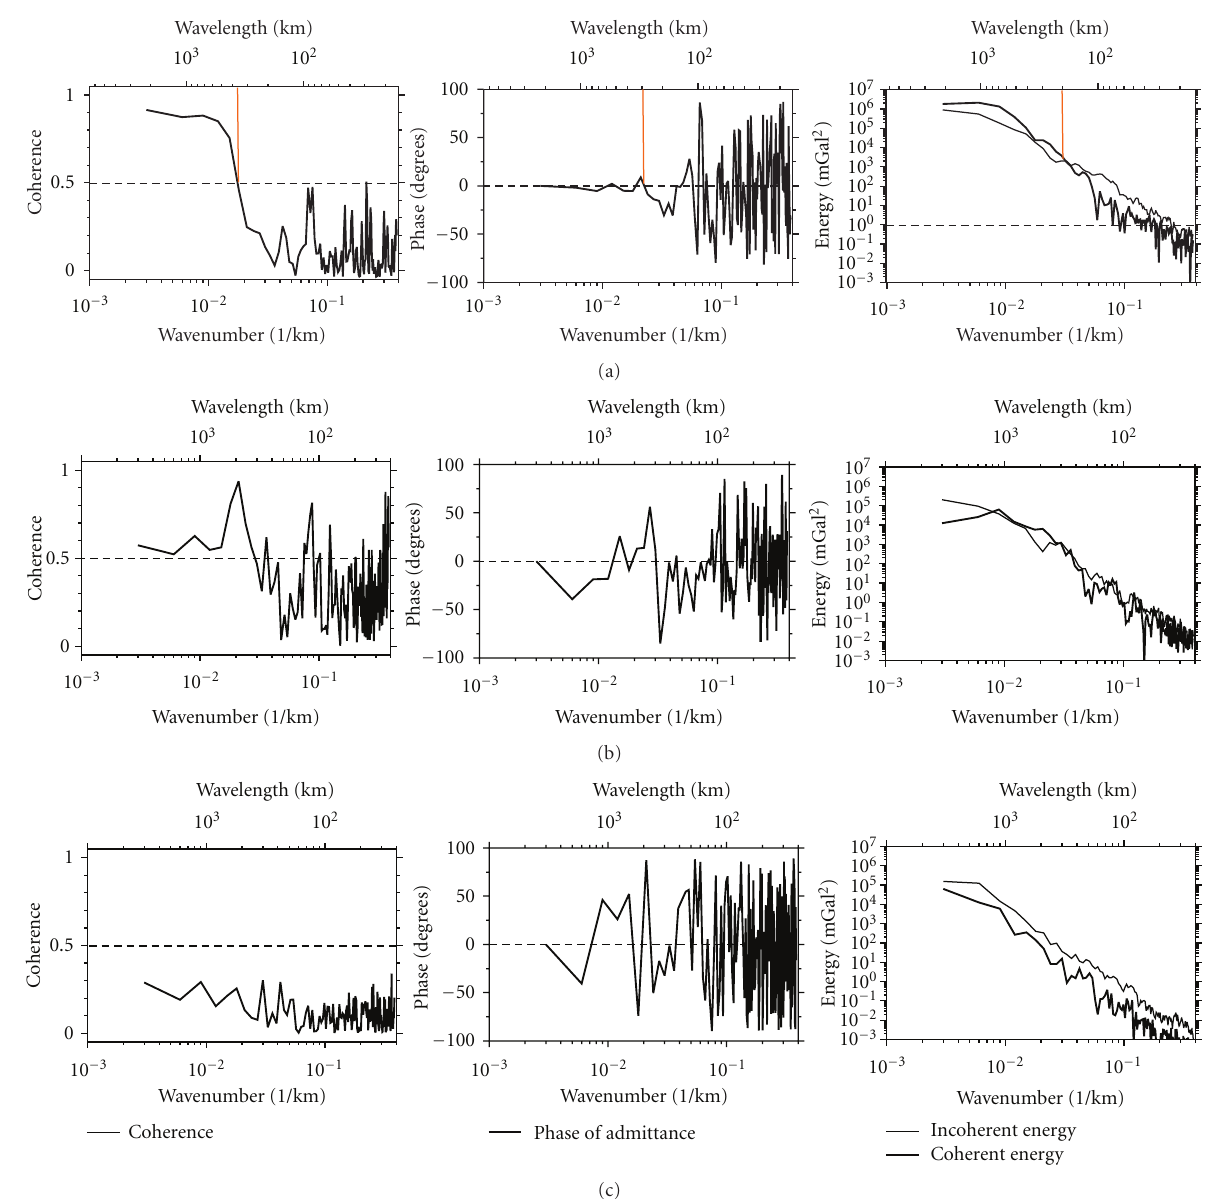
Figure 10: Observed admittance values computed from FAA and topography for areas (a), (b), and (c) in Figure 8. Red lines indicate cuto ff values for coherence, phase, and coherent (thick line) and incoherent (thin line) energies. (a) For M´erida Andes, the coherence is high for k < 0.04, the estimated phase is close to zero for k < 0.08, and the coherent energy is higher than the incoherent energy for values of k < 0.08.